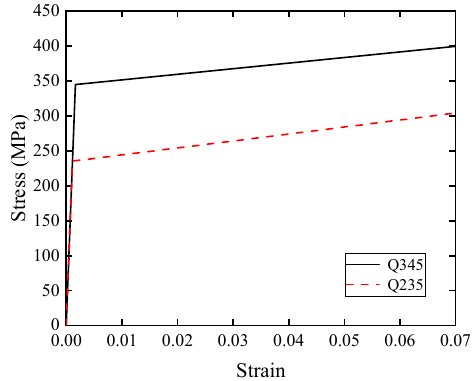
parallel to the transmission line), and torsion were 2.095, 2.107, and 4.856 Hz, respectively.